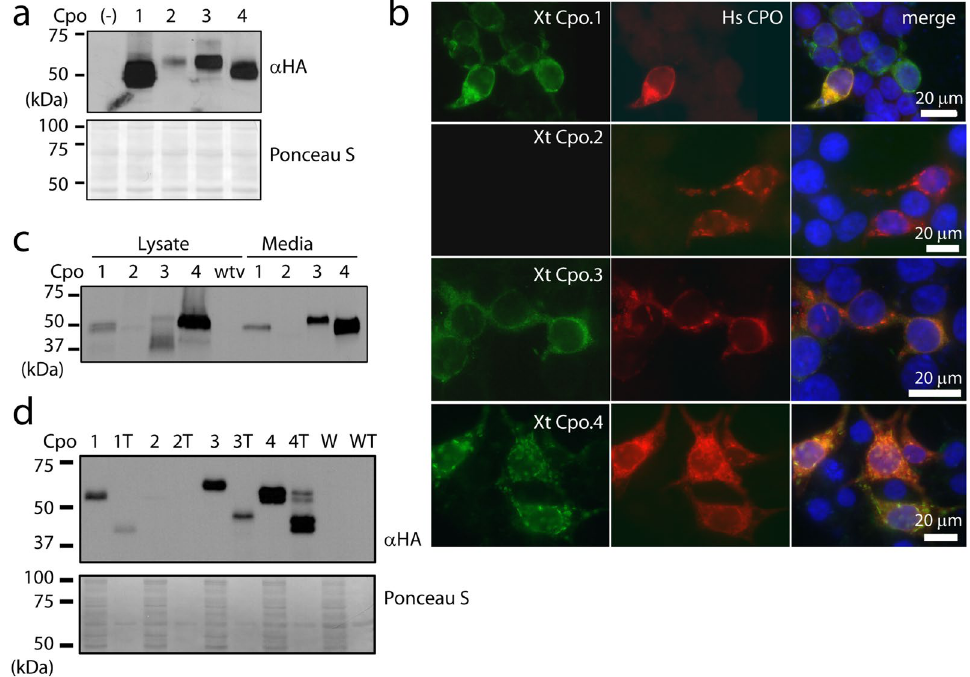
Figure 6. Xenopus tropicalis CPO orthologs are expressed and processed by an endopeptidase. ( a ) HEK293T cells were transfected with plasmids encoding the four HA-tagged X.t. CPO orthologs, or an empty plasmid (−). Cell lysates (equal amounts of protein) were resolved by SDS-PAGE and western blotted with an anti-HA antibody. The nitrocellulose membrane was also stained with Ponceau S as a loading control. ( b ) The distribution of HA-tagged X.t. CPO orthologs (green, HA antibody) was analyzed in transfected HEK293T cells by immunocytochemistry and compared with the distribution of transfected human CPO (red, CPO antibody). ( c ) The four X.t. CPO orthologs were expressed in Sf9 cells using recombinant baculoviruses. Cells were infected with wild-type virus (wtv) as a control. One percent of each cell lysate, or 0.06% of each collected medium, was resolved by SDS-PAGE and western blotted using an HA antibody. ( d ) Sf9 conditioned media (containing cpo.1, 2, 3, or 4, or wild-type virus (W)) and the same media incubated with 2.5 µg/ml trypsin (T) for 5 min at room temperature were resolved by SDS-PAGE and western blotted with an HA antibody. The membrane was stained with Ponceau S as a loading